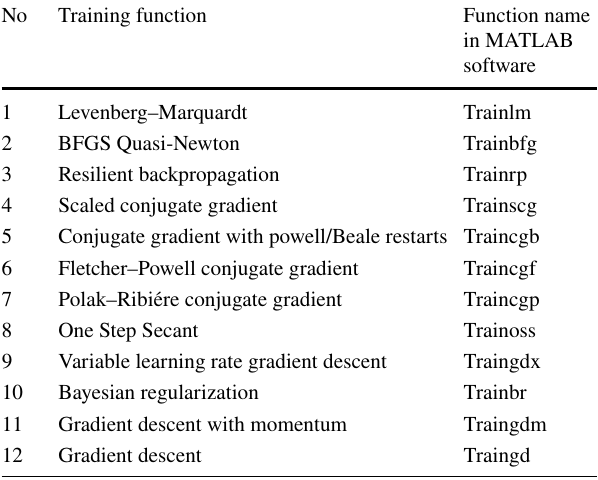
Table 2 Training functions used in this study Table 3 Details of different architectures of ANN and SVR models